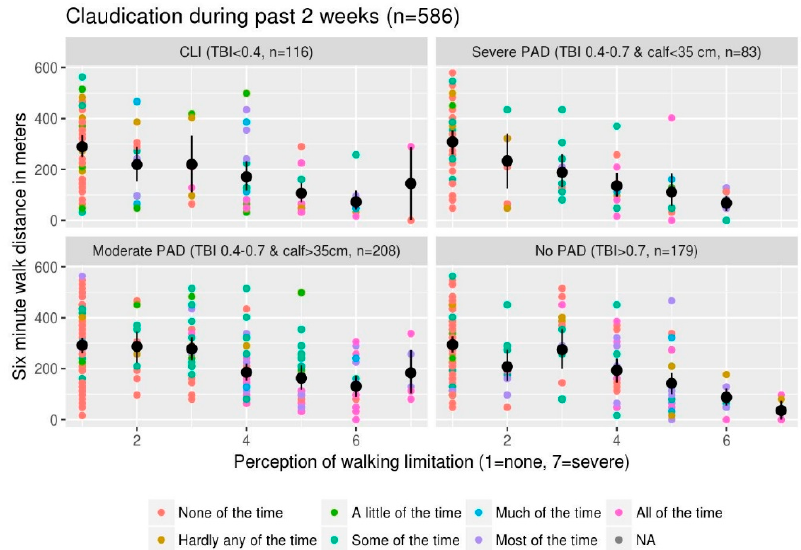
Figure 2. 6MWT distance versus perception of walking limitation: This illustrates the relationship between 6MWT distance, perception of walking limitation from quality-of-life questionnaire and symptoms of claudication in the last 2 weeks. The scatterplot of six-minute walk distance versus perception of limitation where each dot represents a single patient is colored by severity of symptoms using the color scale specified in the legend. The black dots are the mean 6MWT distance for each given category of perception of walking limitation with the bars representing the standard error of mean (SEM). Each panel represents data from patients with various severities of PAD ranging from CLI